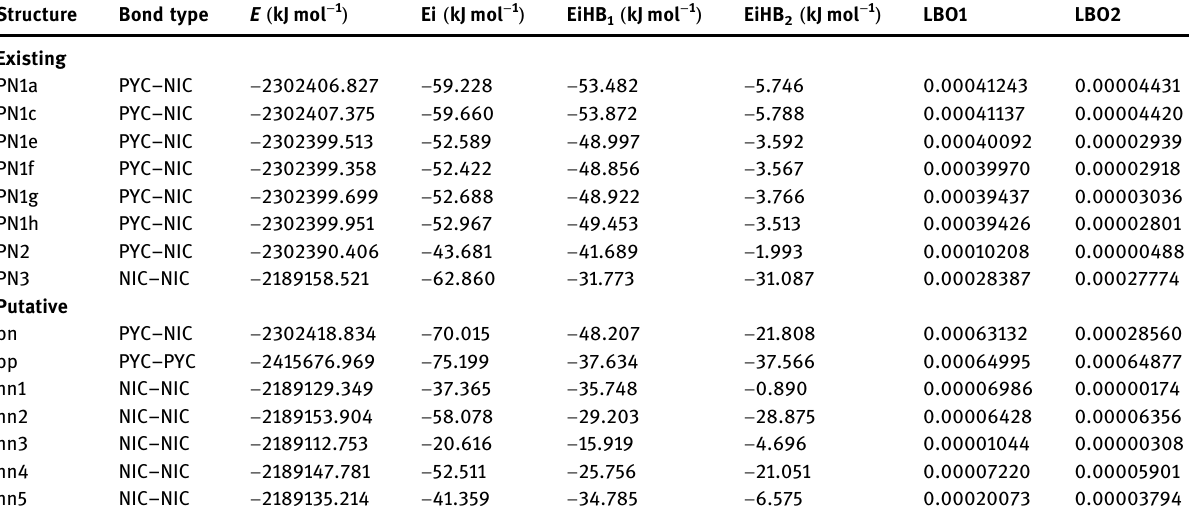
Table 1: Total energy ( E ) , interaction energy ( Ei ) , bond energy, and Laplacian bond order ( LBO ) of PYCNIC